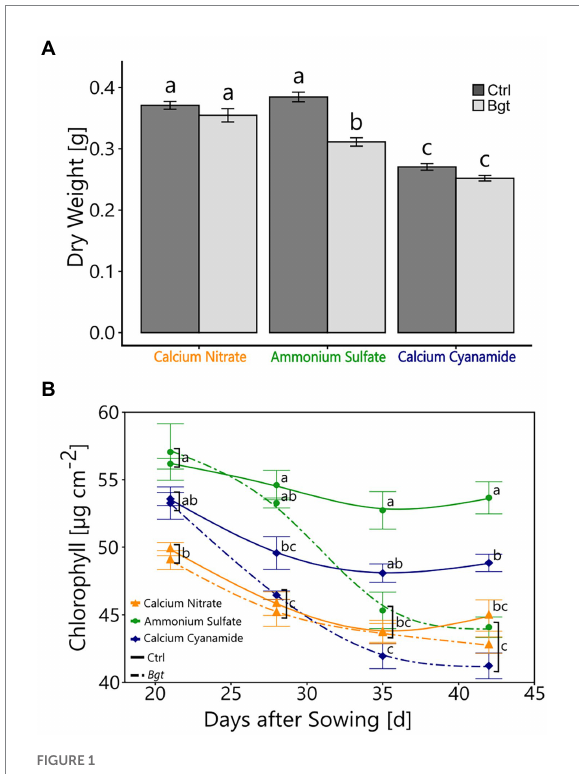
FIGURE 1 Plant performance with different N fertilizers and Bgt infection. (A) Plant dry weight (g) of winter wheat plants 28 days post- infection. (B) Chlorophyll content ( μ g cm − 2 ) of winter wheat plants 21, 28, 35, and 42 days after sowing, treated with different nitrogen forms (calcium nitrate, ammonium sulfate, calcium cyanamide) under control conditions and Bgt infection. Data represent mean values of three biological replicates ± SE. The different lowercase letters indicate significant differences at 0.05 probability level according to Tukey multiple comparison test.